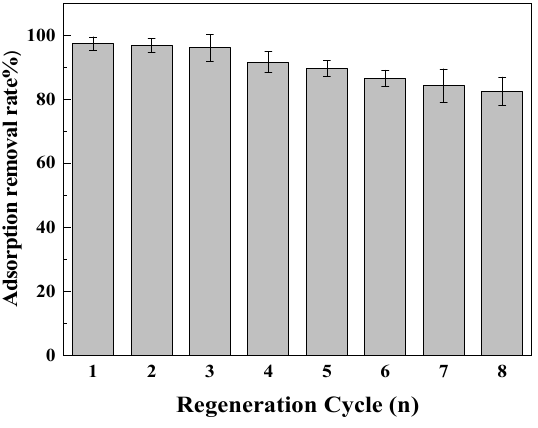
Figure 12. Regeneration properties of MDG.